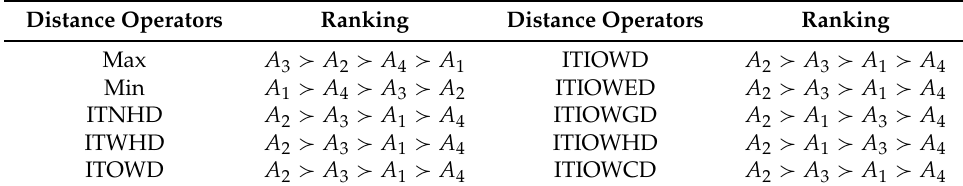
Table 8. Ranking of the